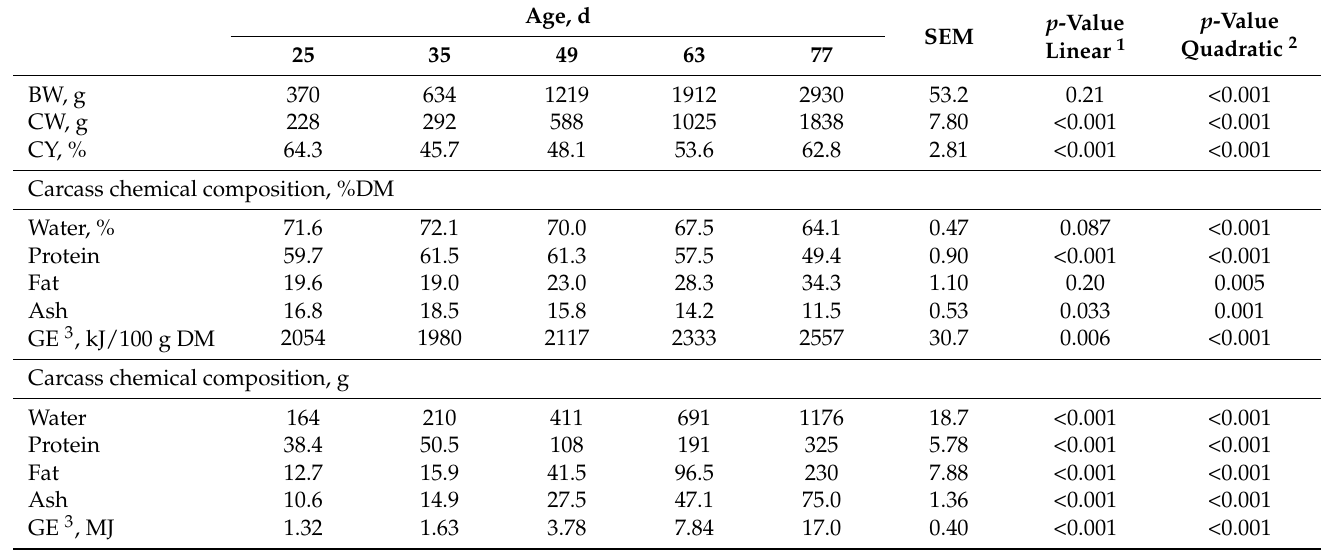
Table 4. Body weight, carcass weight (CW), carcass yield (CY) and analyzed carcass composition (expressed as a percentage and in grams) of the of the calibration-group rabbits at 25, 35, 49, 63, and 77 d of age ( n =